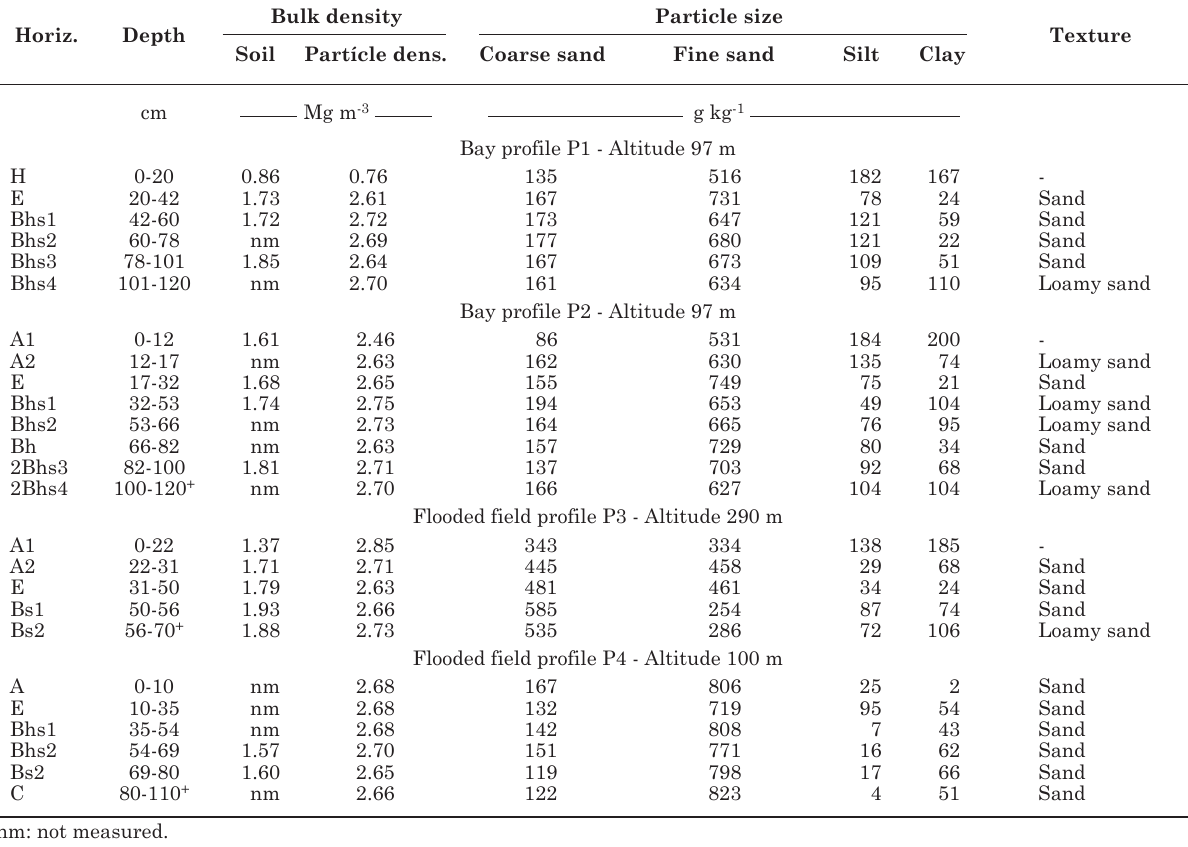
2. Bulk density, particle size and texture of soils developed from sediments of the river taquari